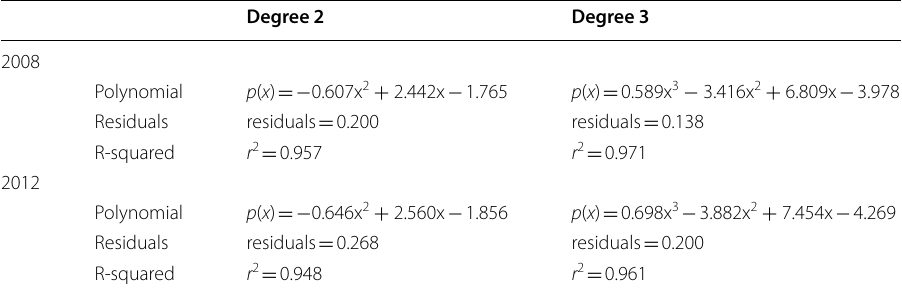
Numbers before the x are the coefficients of the polynomial and the variable x stands for the independent variable, in this case aggregate effect Spearman correlation coefficients matrix